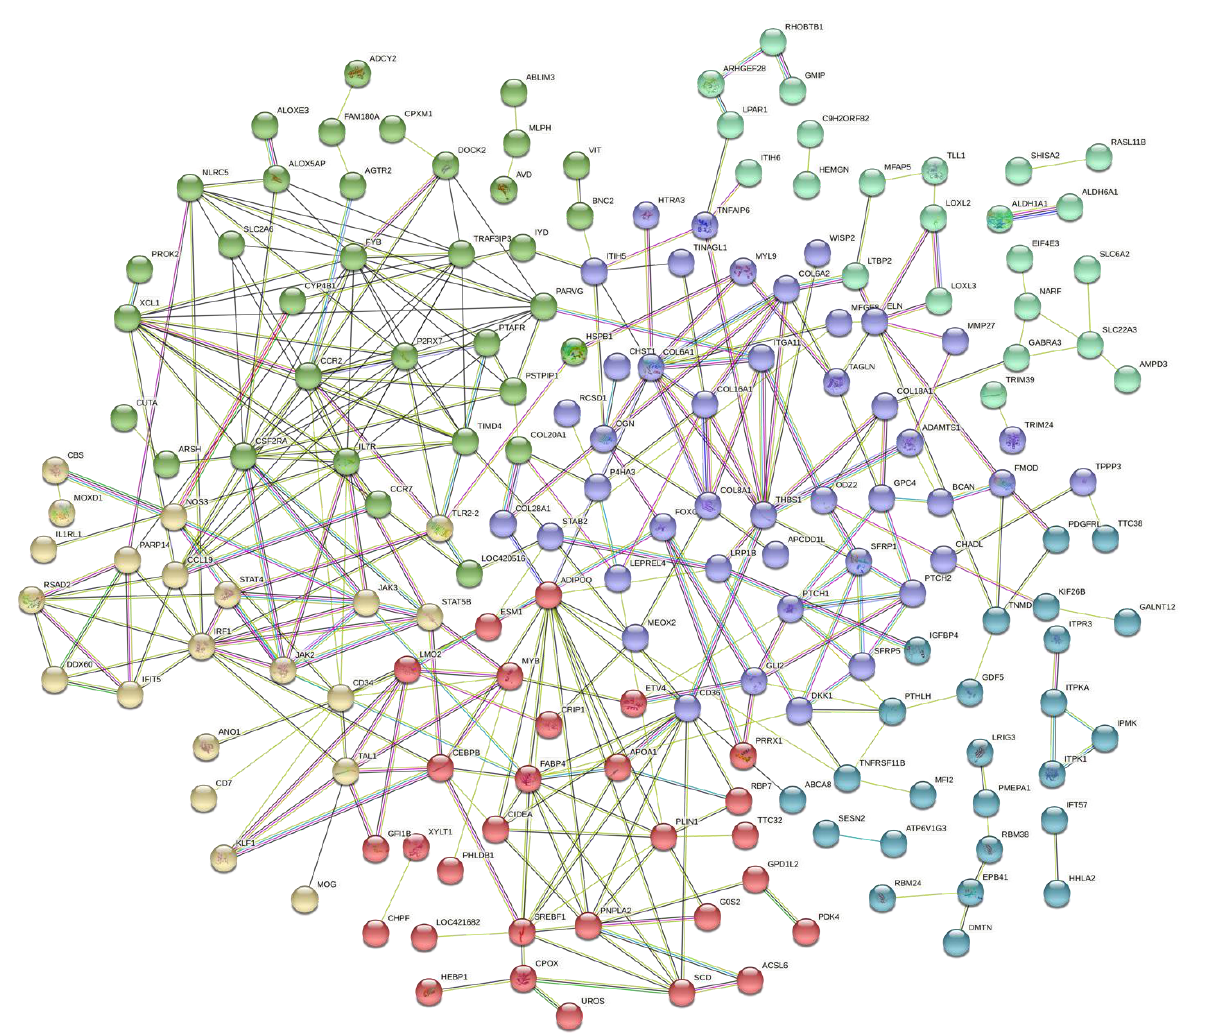
Figure 4. Gene network of unique DE genes in the femoral growth plate of normal and FHS-affected broilers using STRING. Colored circles represent genes with similar functions or acting in similar pathways, and lines represent the predicted interactions between genes.